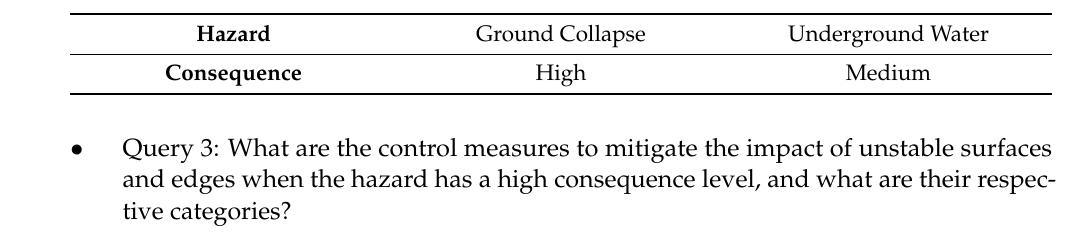
Table 7. The result of Query 3, in a tabular form.